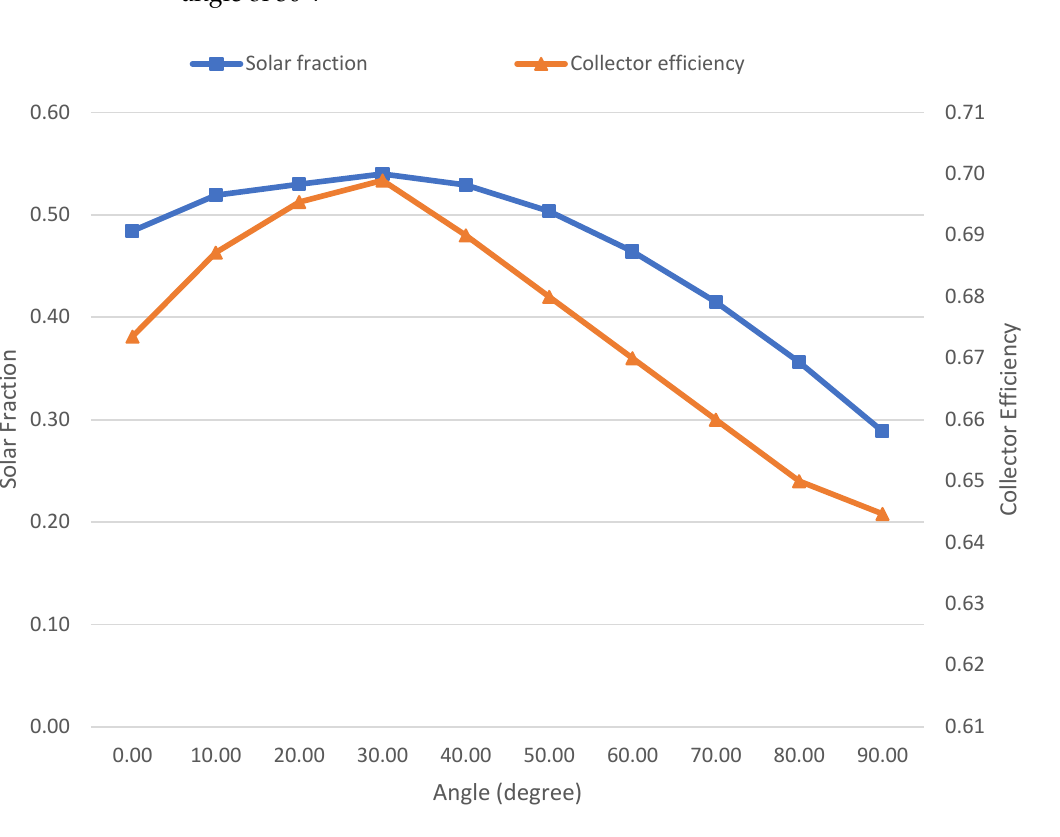
Figure 5. Effect of slope on collector efficiency and solar fraction.